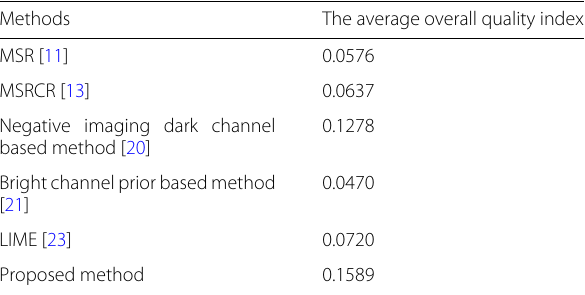
Table 1 Comparison of the average overall quality index of different